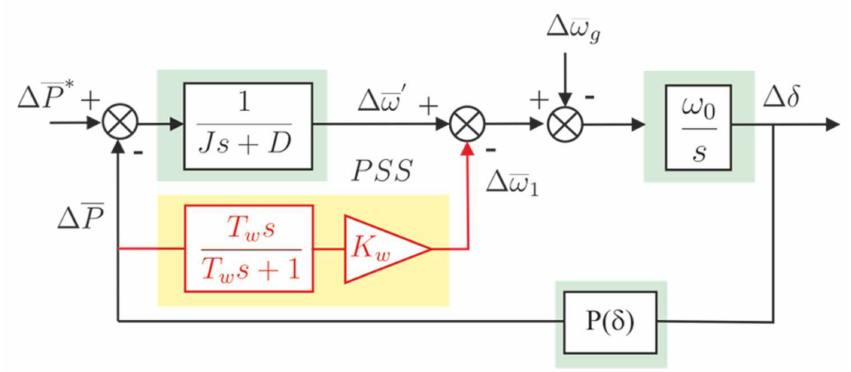
Figure 8. PSS integration in the power synchronization